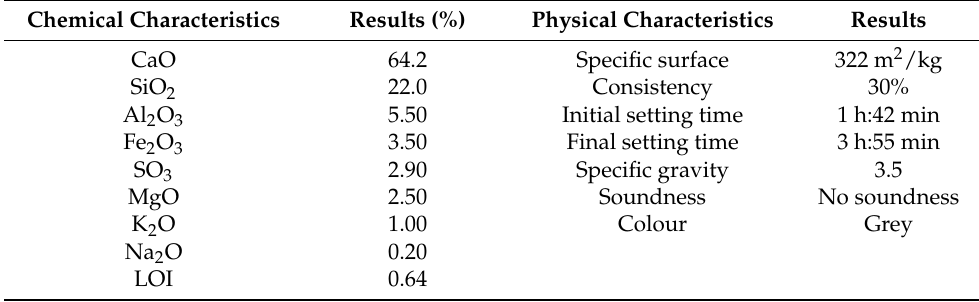
Table 2. The chemical and physical characteristics of type II OPC used for control specimens.